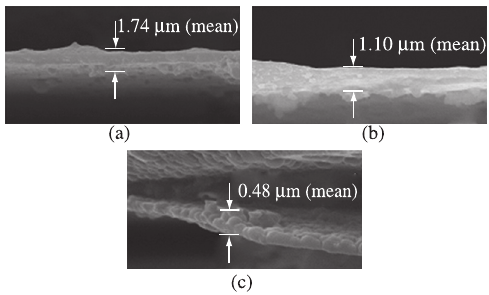
Figure 2. Thickness of the films deposited for (a) 120, (b) 90 and (c) 60 minutes.